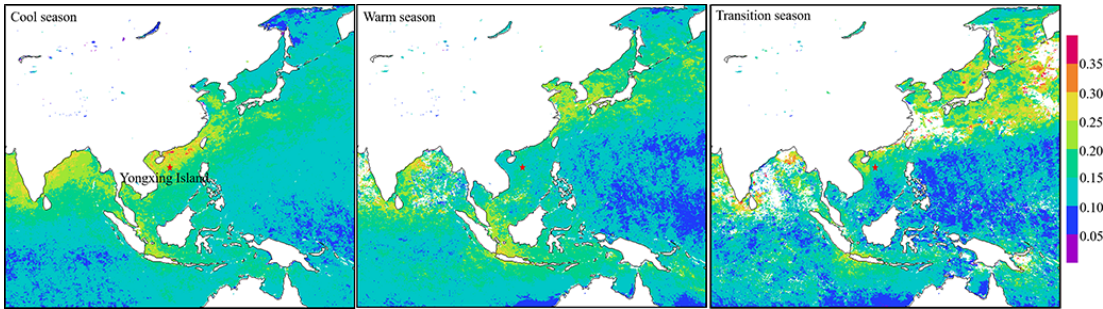
Figure 1. Distribution of seasonal average aerosol optical thickness (AOT) at 550nm (T550) over northwestern Pacific in cool, warm and transition seasons during sampling period. Monthly AOT products (from Moderate Resolution Imaging Spectrometer, MODIS) with 4km resolution were downloaded from GlobColour (http://hermes.acri.fr/). The GlobColour project began in 2005 as an ESA Data User Element project to provide a continuous dataset of merged level 3 ocean color products.